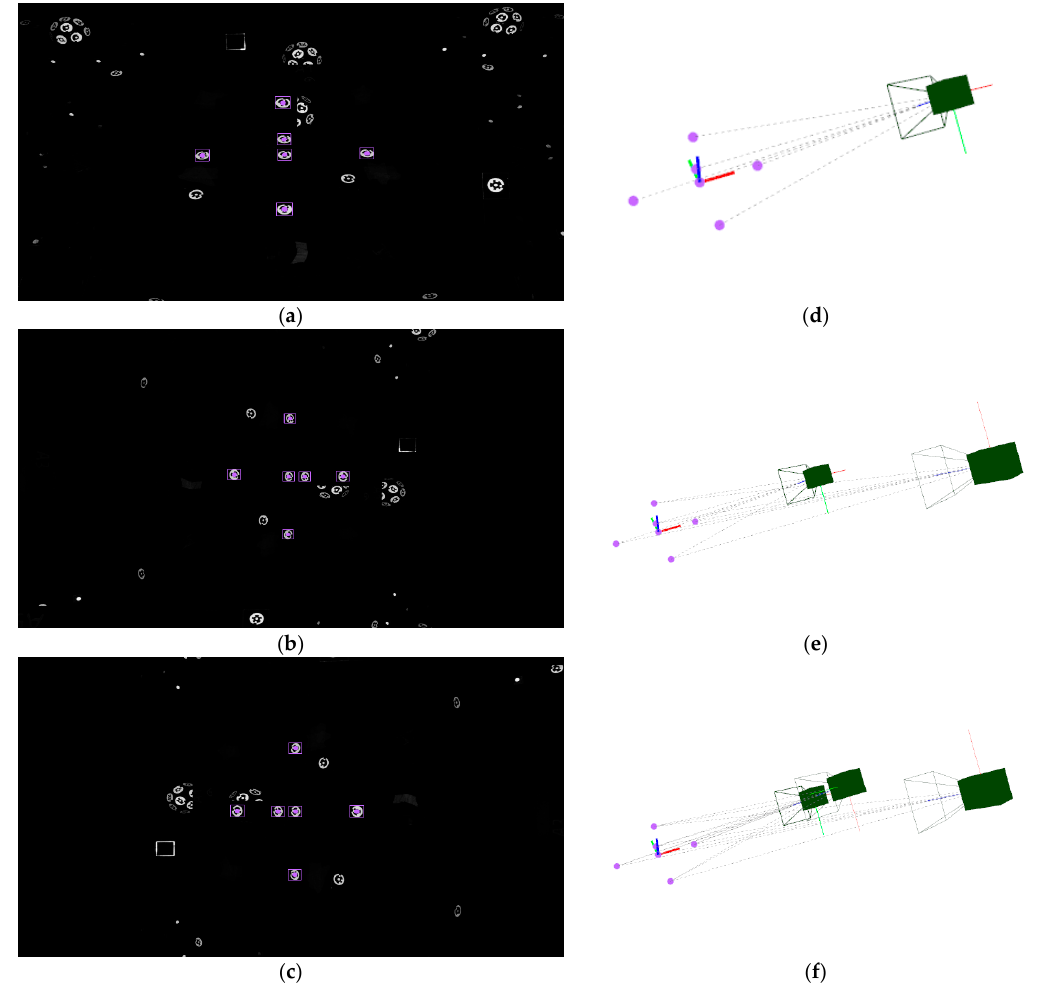
Figure 7. Computing of initial approach of a new camera extrinsic parameters. First set of three images is shown ( a – c ), where coded targets on measuring reference frame are detected (highlighted in purple on each image). Camera frames according to computed extrinsic parameters are depicted in ( d , e ), and ( f ) corresponding to each image ( a – c ), respectively, along with the epipolar net for each image to the set of detected targets in the measuring reference frame (purple).